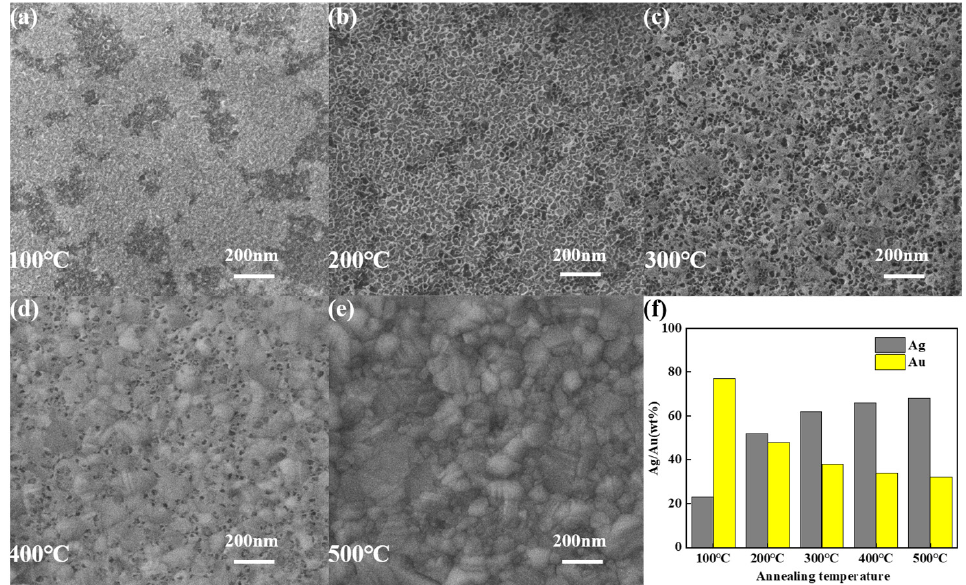
Figure 2. The SEM images of the Au-Ag composite nanostructures with different temperature of ( a ) 100 °C, ( b ) 200 °C, ( c ) 300 °C, ( d ) 400 °C, ( e ) 500 °C, ( f ) The Au-Ag weight ratio as a function of annealing temperature.